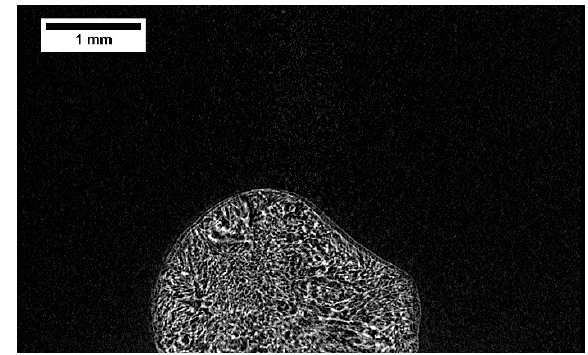
Figure 5. Sectional view of a dried 20% (w/w) sucrose particle.